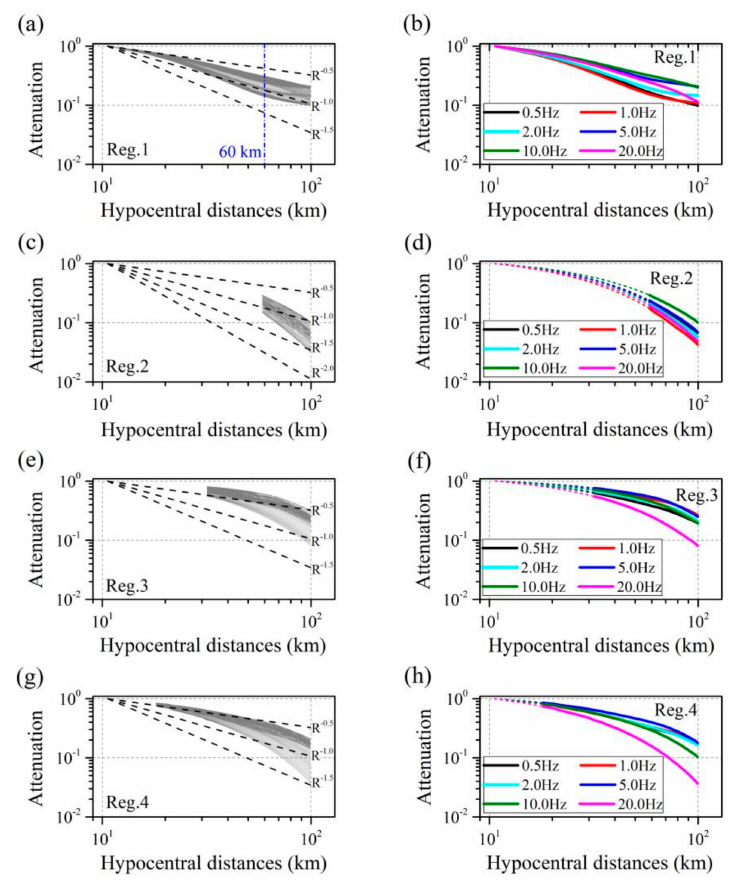
Figure 7. 0.25–20 Hz attenuation curves of ( a ) Reg.1, ( c ) Reg.2, ( e ) Reg.3, and ( g ) Reg.4 and comparison with R − 0.5 , R − 1.0 , R − 1.5 and R − 2.0 curves. 0.5 Hz, 1.0 Hz, 2.0 Hz, 5.0 Hz, 10 Hz, and 20 Hz attenuation curves of ( b ) Reg.1, ( d ) Reg.2, ( f ) Reg.3, and ( h )